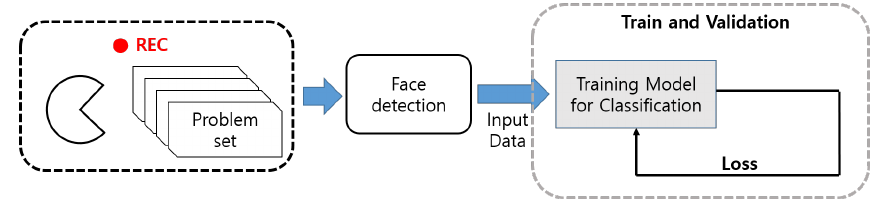
Figure 4. Overall flow of a system for classifying facial expressions using